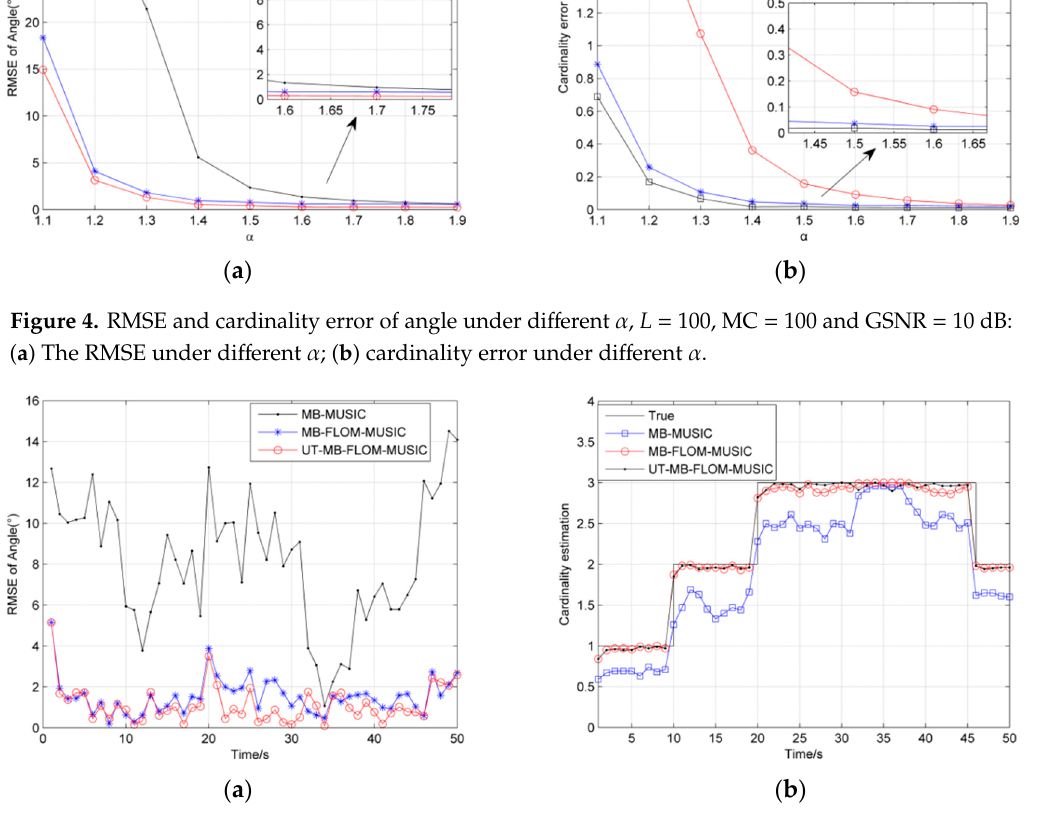
Figure 5. RMSE and Cardinality estimation of angle under α = 1.3 and GSNR = 10 dB, MC = 100: ( a ) RMSE of angle; ( b ) Cardinality estimation of angle.